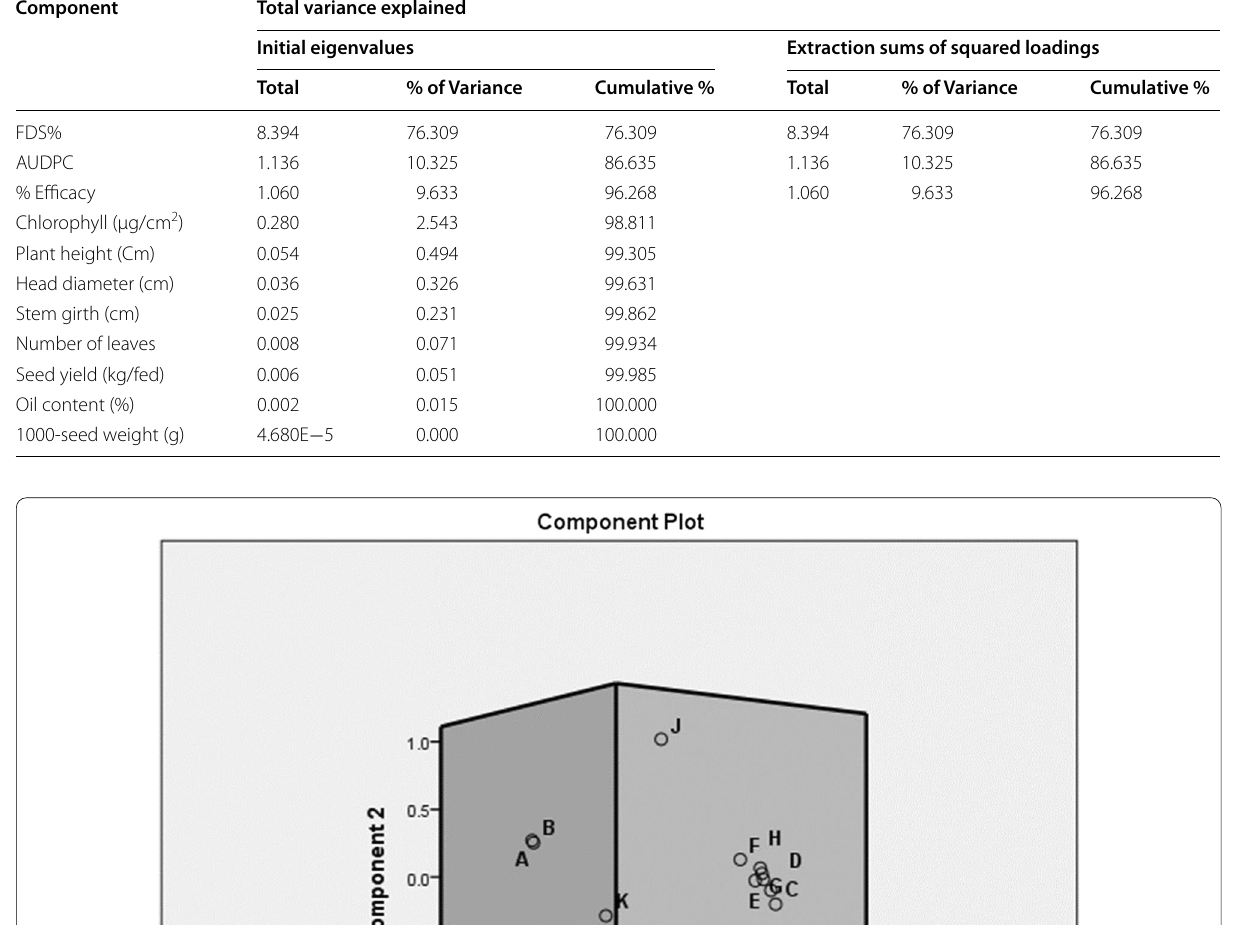
Table 6 Loadings between the first two principal components of disease parameters, plant growth parameters and yield components extracted from Varimax with Kaiser normalization for sunflower powdery mildew disease in the pooled data of 2019 and 2020 seasons